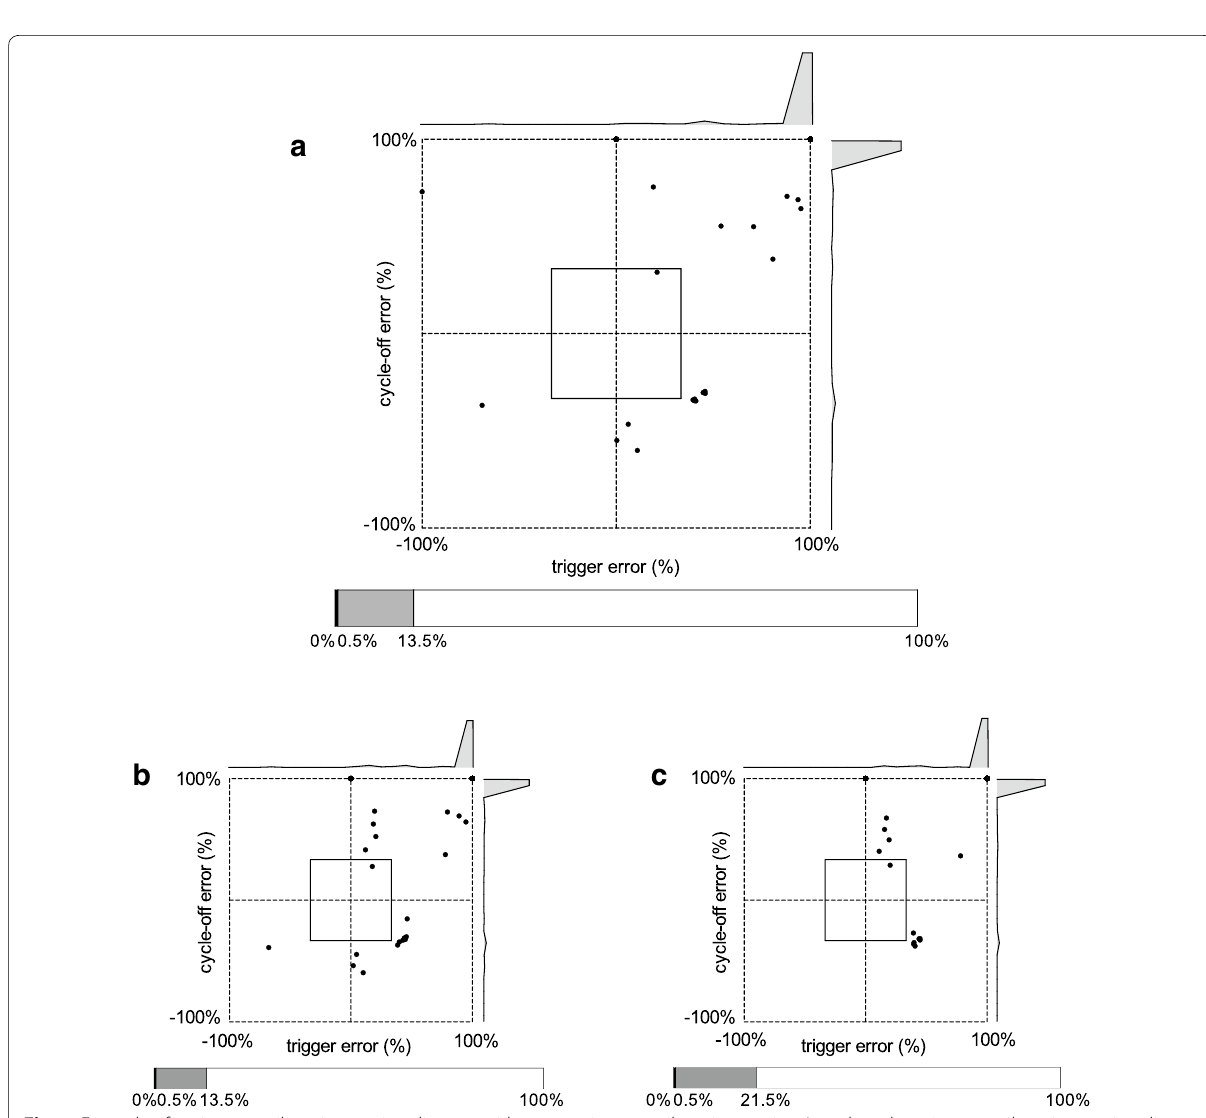
Table 2 Inter-rater and inter-method agreement